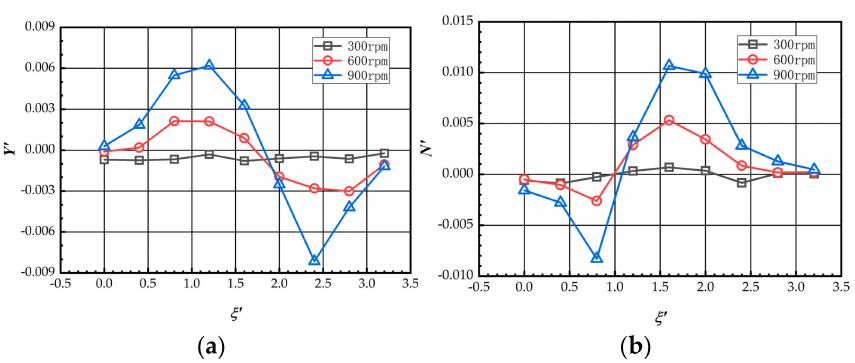
Figure 14. ( a ) The lateral force of DS at different propeller speeds; ( b ) The yaw moment of DS at different propeller